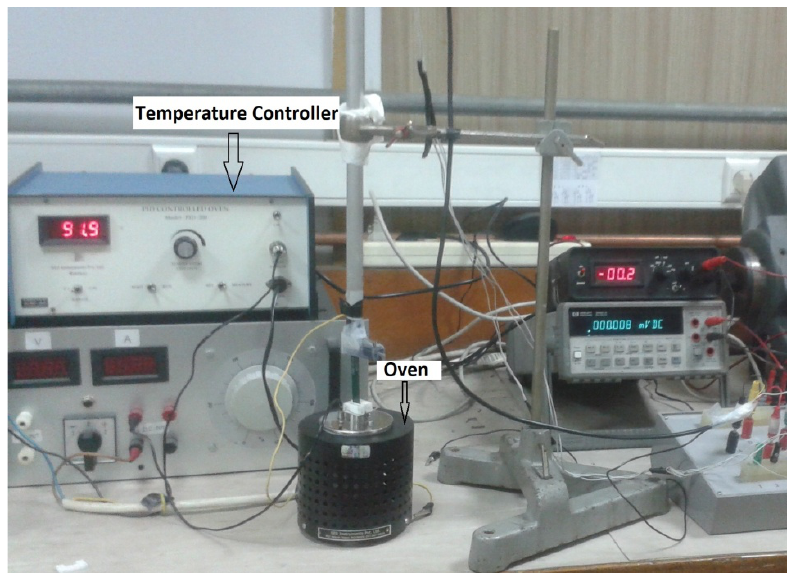
Figure A4. Static calibration setup for temperature coefficient of resistance (TCR) determination of CNT film.